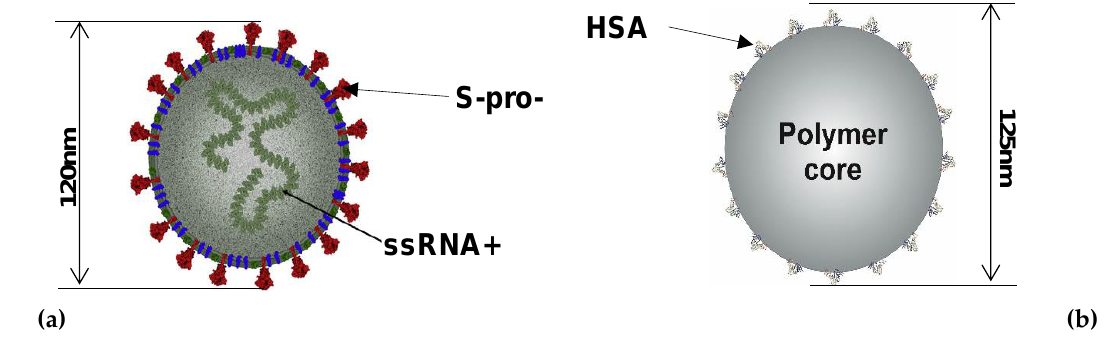
Figure 6. ( a ) A schematic view of the SARS-CoV-2 virion [37] and ( b ) the polymer particle with the HSA corona.